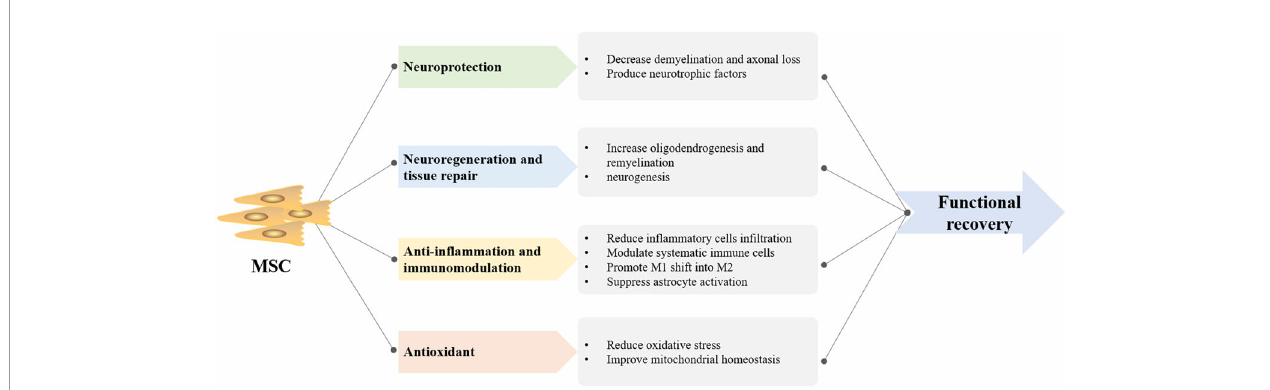
FIGURE 5 | The summary of mesenchymal stem cell (MSC)-derived therapeutic mechanism in multiple sclerosis (MS). M1, proin fl ammatory subtypes of microglia; M2, anti-in fl ammatory subtypes